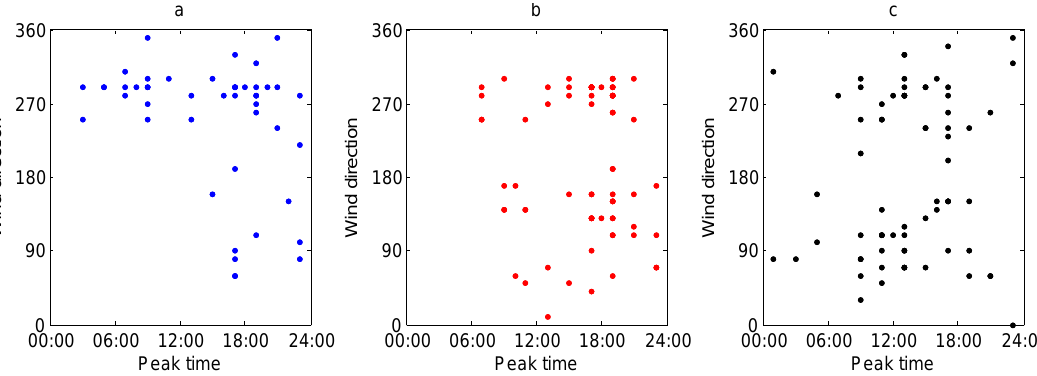
Fig. 6. Scatter plots showing time of the peak against concurrent wind direction for (a) Period 1, n = 37; (b) Period 2, n = 58; and (c) Period 3, n =